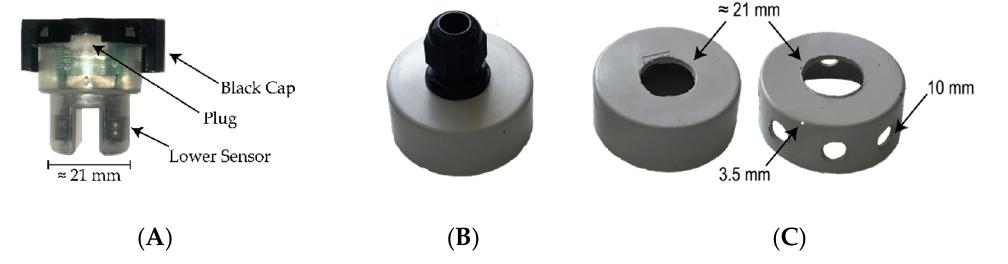
Figure A2. ( A ) Amphenol sensor. ( B ) Third PVC cap and cable gland. ( C ) Two caps produced in step 1 for forming the bottom of the sensor assembly.